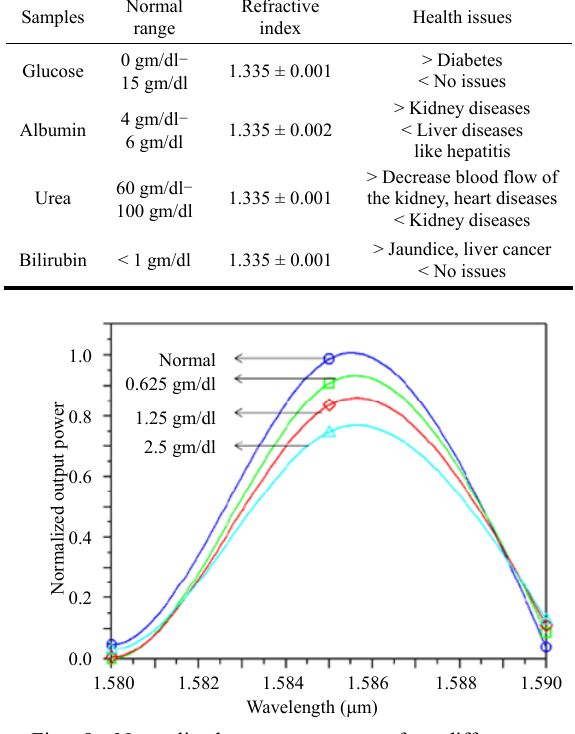
Fig. 9 Normalized output power for different urea concentrations in urine.